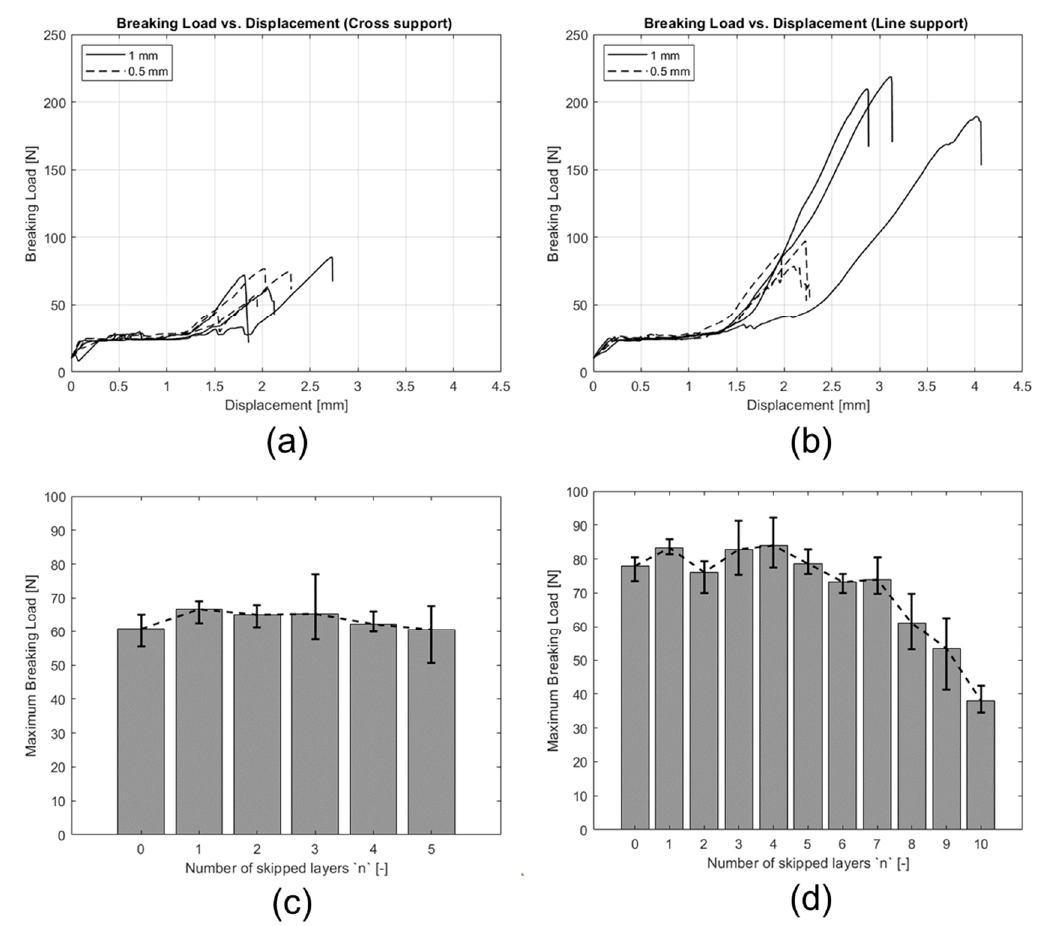
Figure 9. Breaking load vs. displacement plots for two different strut thicknesses, 0.5 mm and 1 mm, for ( a ) cross support, ( b ) line support. Maximum breaking load vs. number of skipped layers for ( c ) cross support, ( d ) line support .